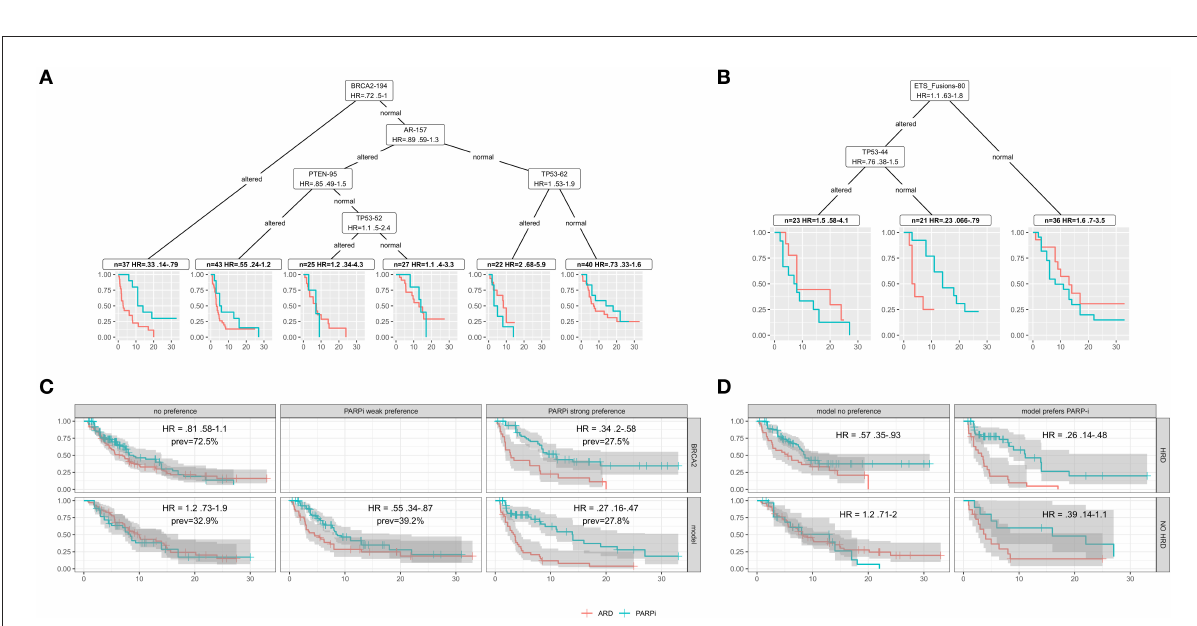
A tree built on all the patients in the Chinnaiyan paper (Figure 7B) identifies an ETS fusion subgroup negative for TP53 alteration with a strong PARPi preference. This subgroup provides evidence for molecular theories. ETS fusions are